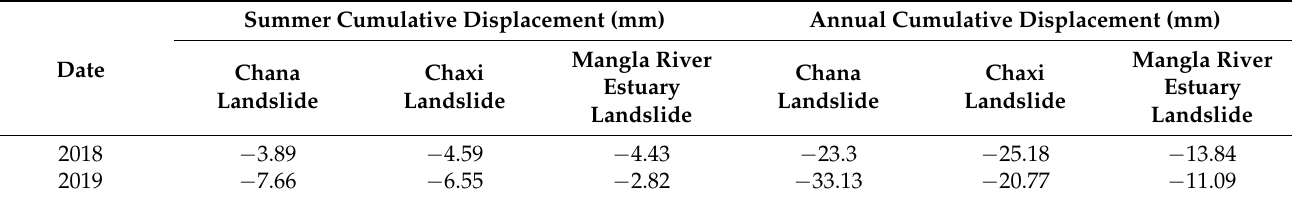
Table 7. Cumulative displacement and annual cumulative displacement of the Chana, Chaxi, and Mangla River Estuary landslides in